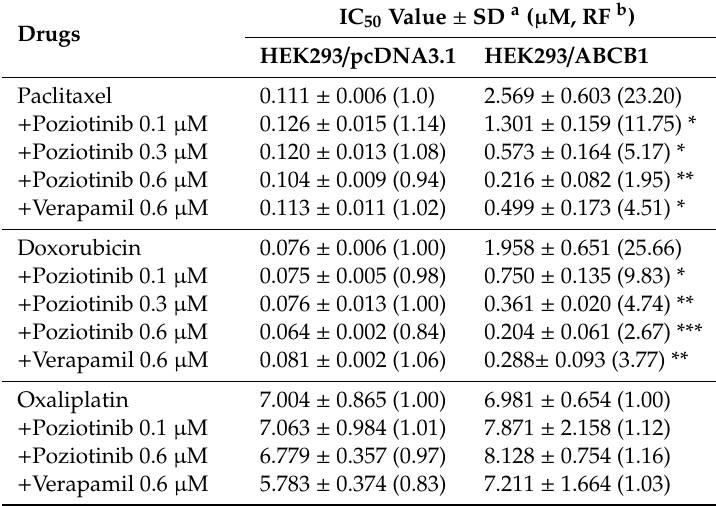
Table 4. The e ff ect of poziotinib and verapamil on the e ffi cacy of paclitaxel, doxorubicin and oxaliplatin in ABCB1 gene-transfected HEK293 cells overexpressing the ABCB1